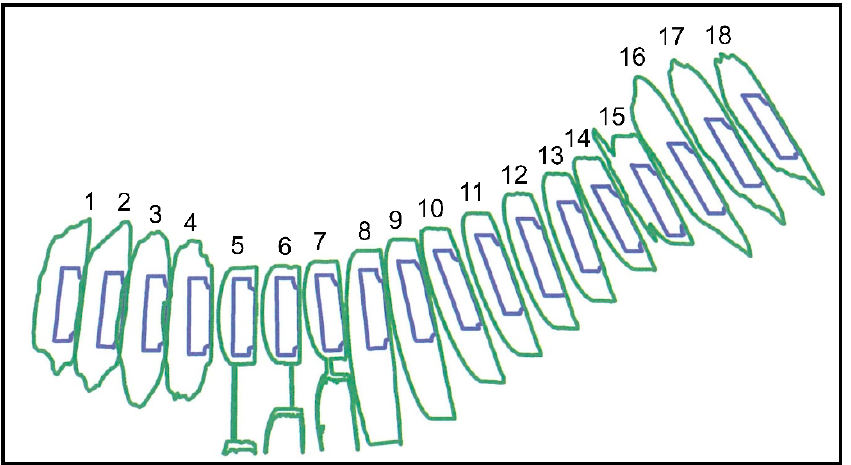
Figure 15. 3D model for the purpose of analysis of collision possibility.